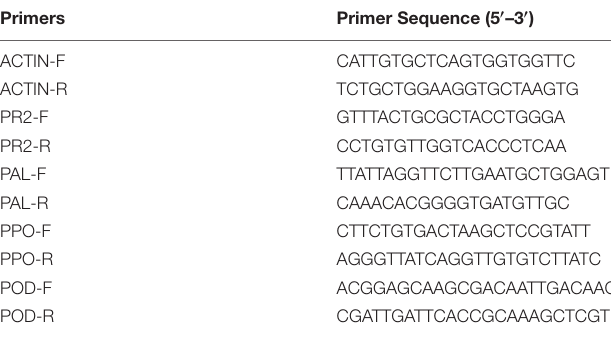
TABLE 2 | A list of primers sequence for qRT-PCR